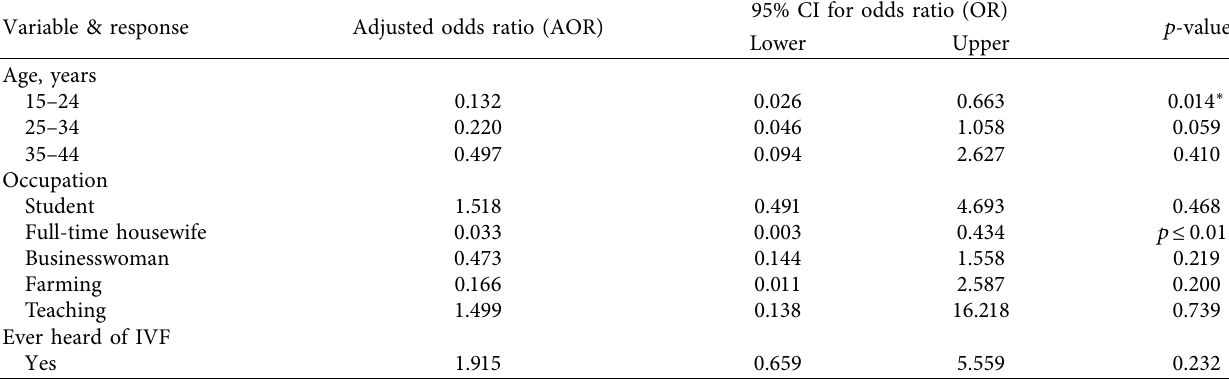
Table 9: Respondents’ likelihood of having a positive overall perception about IVF